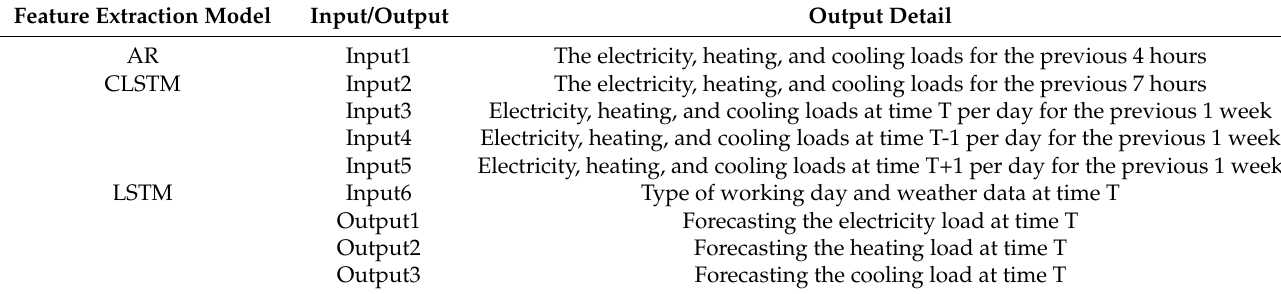
Table 1. Model input/output